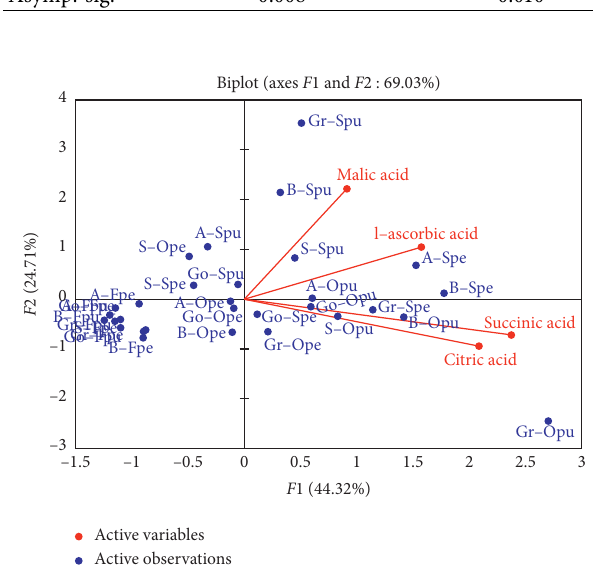
Figure 1: Biplot graph of organic acids (scores and loading plots) obtained from principal component analysis (abbreviations; A-Fpe: Amasya fresh peel; A-Fpu: Amasya fresh pulp; A-Ope: Amasya oven-dried peel; A-Opu: Amasya oven-dried pulp; A-Spe: Amasya sun-dried peel; A-Spu: Amasya sun-dried pulp; B: Braeburn; Go: Golden Delicious; Gr: Granny Smith; S: Starking).